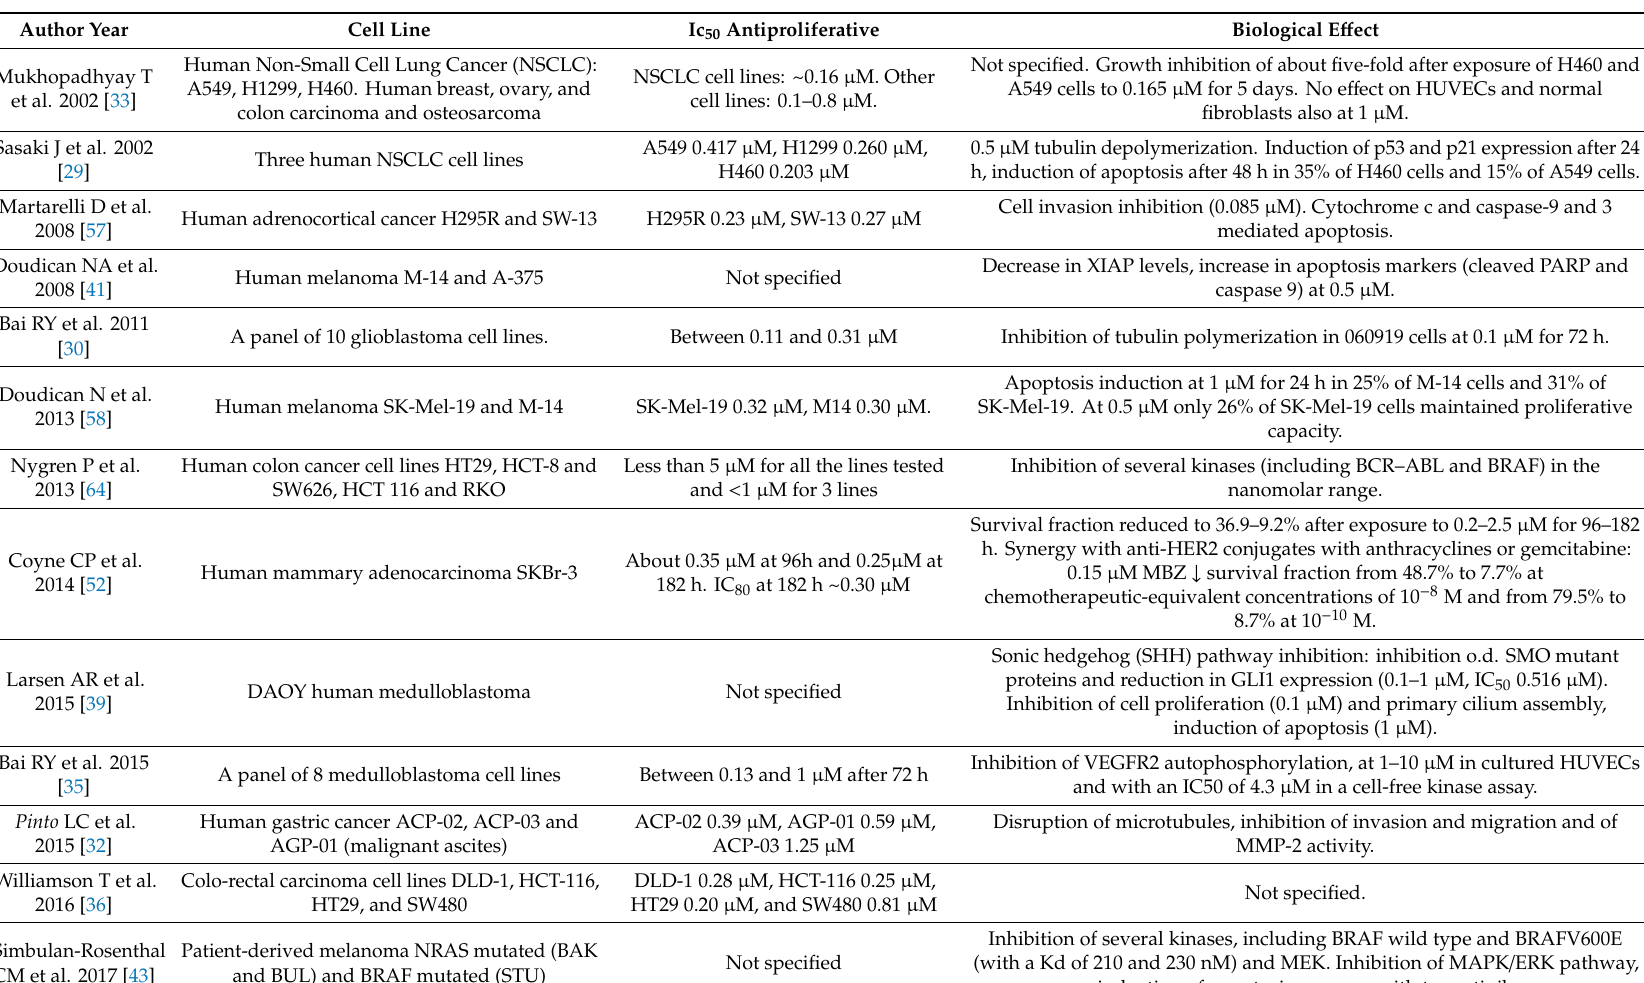
Table 3. Studies reporting MBZ anticancer activity in vitro and its mechanisms of action. IC 50 = half maximal inhibitory concentration; EC 50 = concentration required to achieve a half-maximal e ff